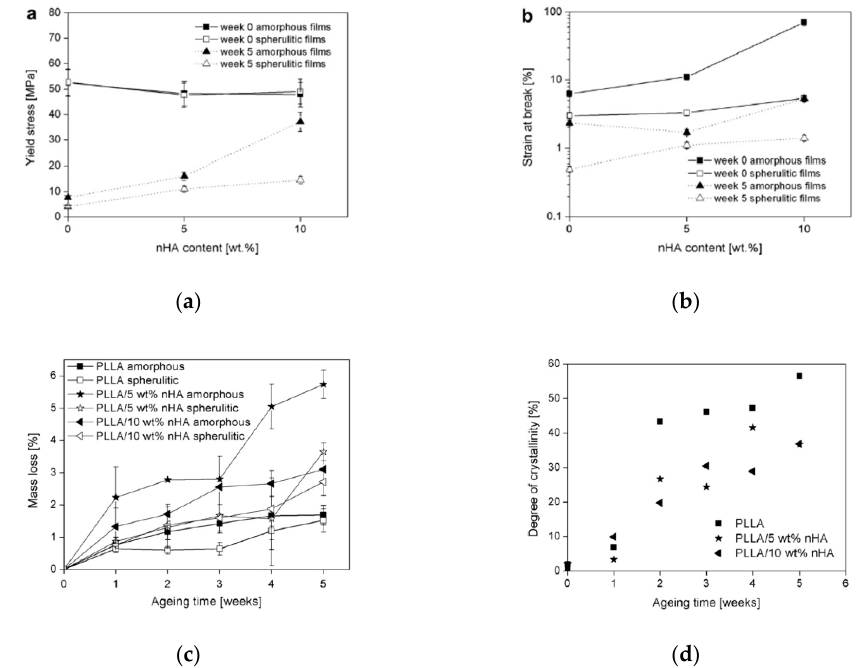
Figure 8. ( a ) Yield strength and ( b ) strain at break for poly-L-lactic acid (PLLA) samples before and after 5 weeks of aging as a function of hydroxyapatite (nHA) content. ( c ) Mass loss and ( d ) degree of crystallinity for amorphous sample, as a function of the aging time for PLLA containing nHA at 0, 5, and 10 wt.% [42], Reproduced with permission from Delabarde C, Polym. Degrad. Stab.; published by Elsevier, 2011.